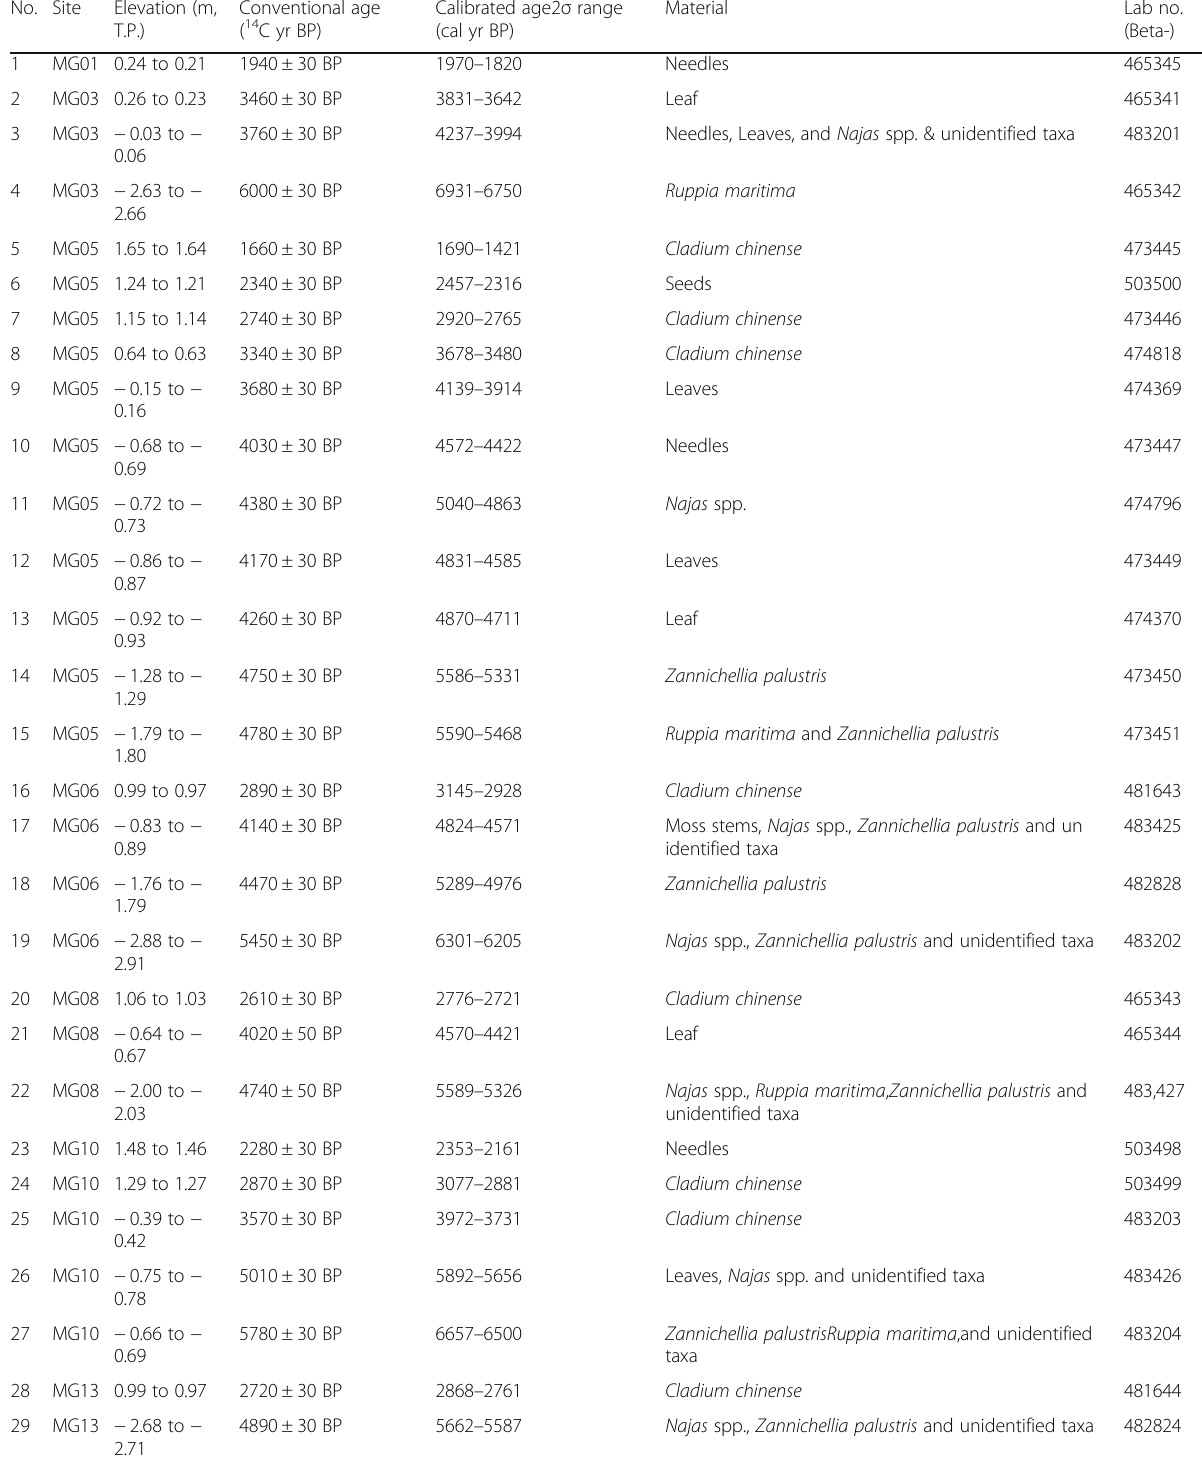
Table 2 Radiocarbon ages from Mugi